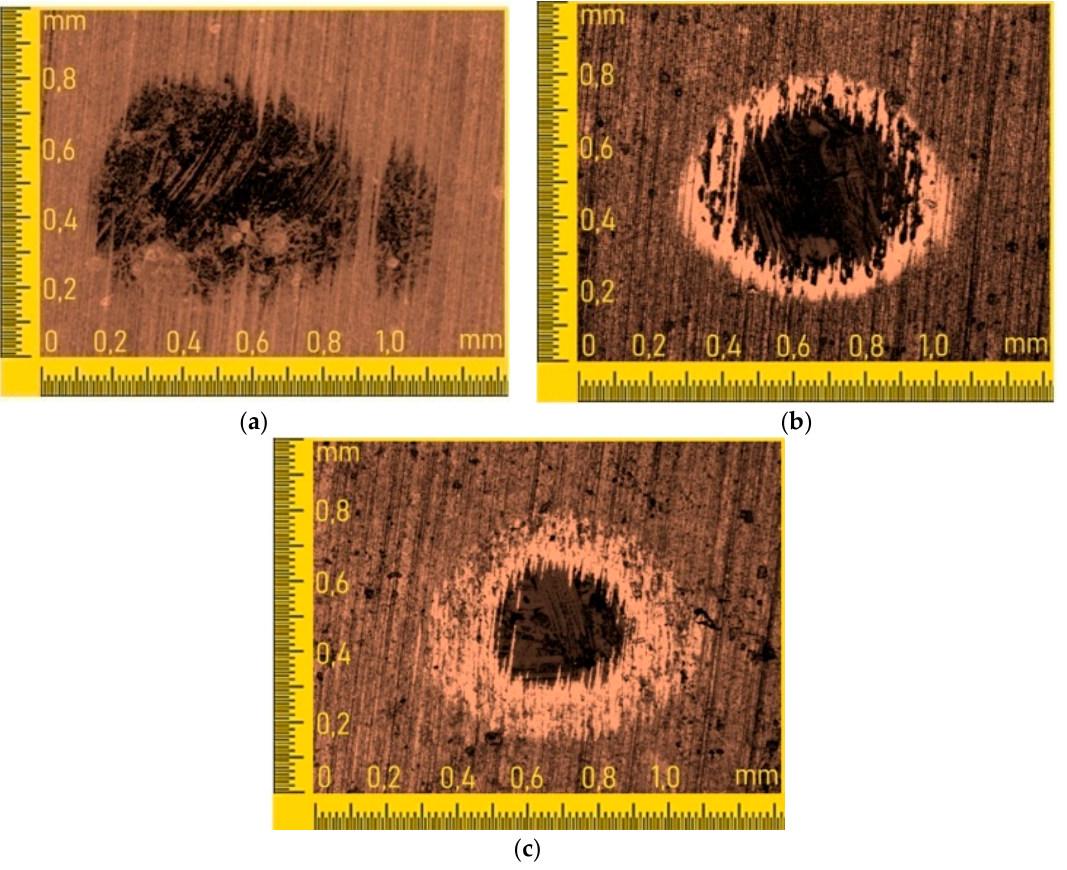
Figure 9. 2D images of the worn hole on 6WH10F carbide samples after surface layer abrasion resistance tests: ( a ) uncoated; ( b ) DLC-coated; and ( c ) (CrAlSi)N/DLC-coated.